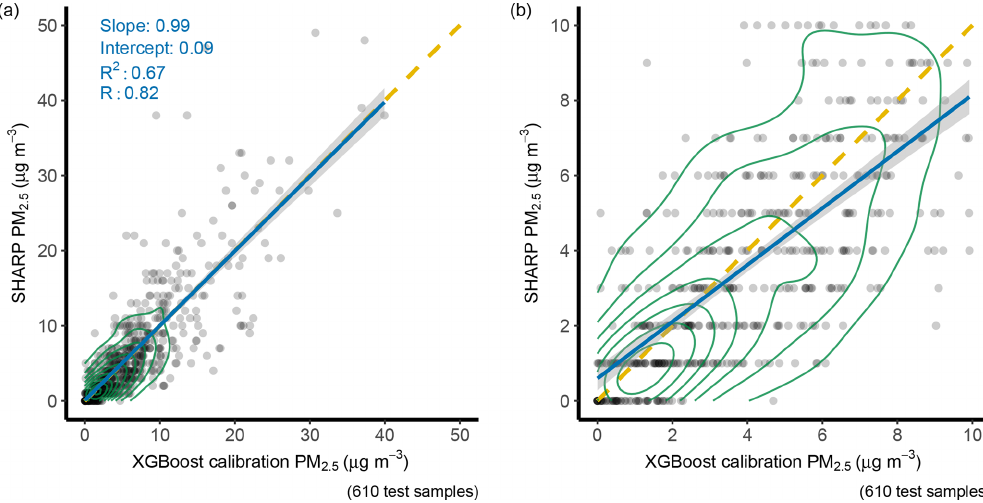
Figure 12. Comparison between the XGBoost predictions and SHARP. Based on 610 test examples. NN: neural network. Panel (a) is in full scale. Panel (b) is a zoom-in plot of panel (a) . The solid blue line is a regression line. The yellow dashed line is a 1 : 1 line. The green circle represents data density. The grey area along the regression line represents 1 standard